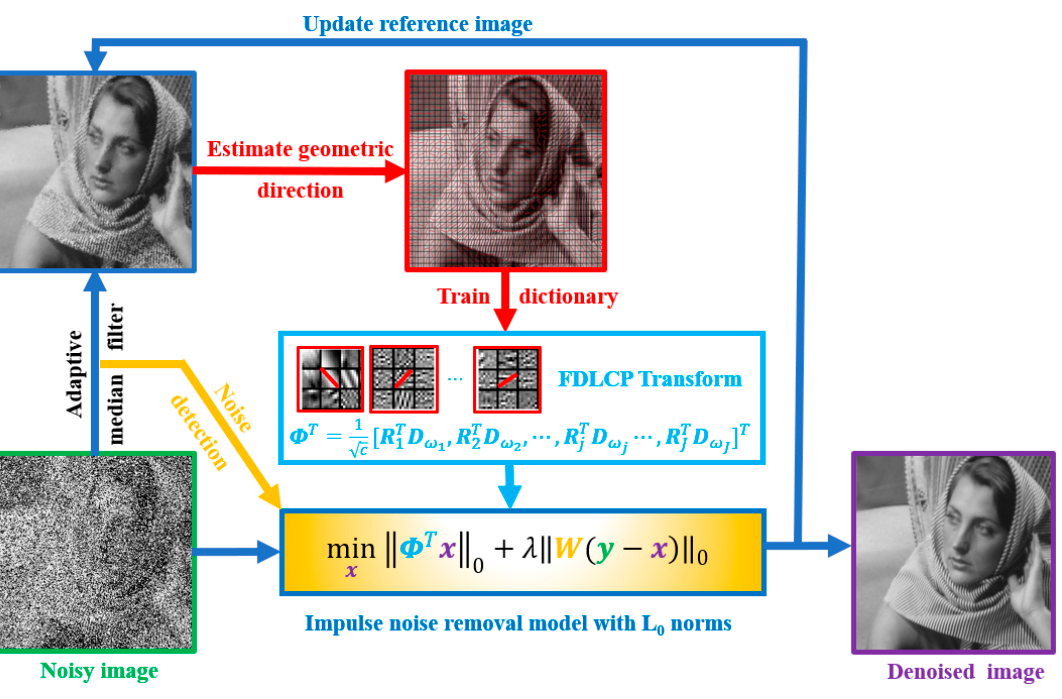
Figure 1. A flowchart of the proposed method on impulse noise removal.